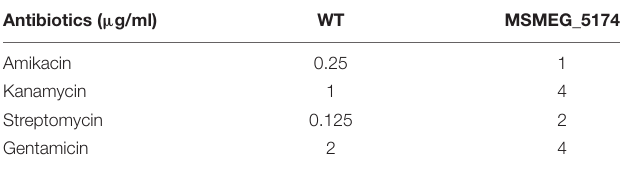
TABLE 2 | The MIC of WT and (cid:49) MSMEG_5174 to